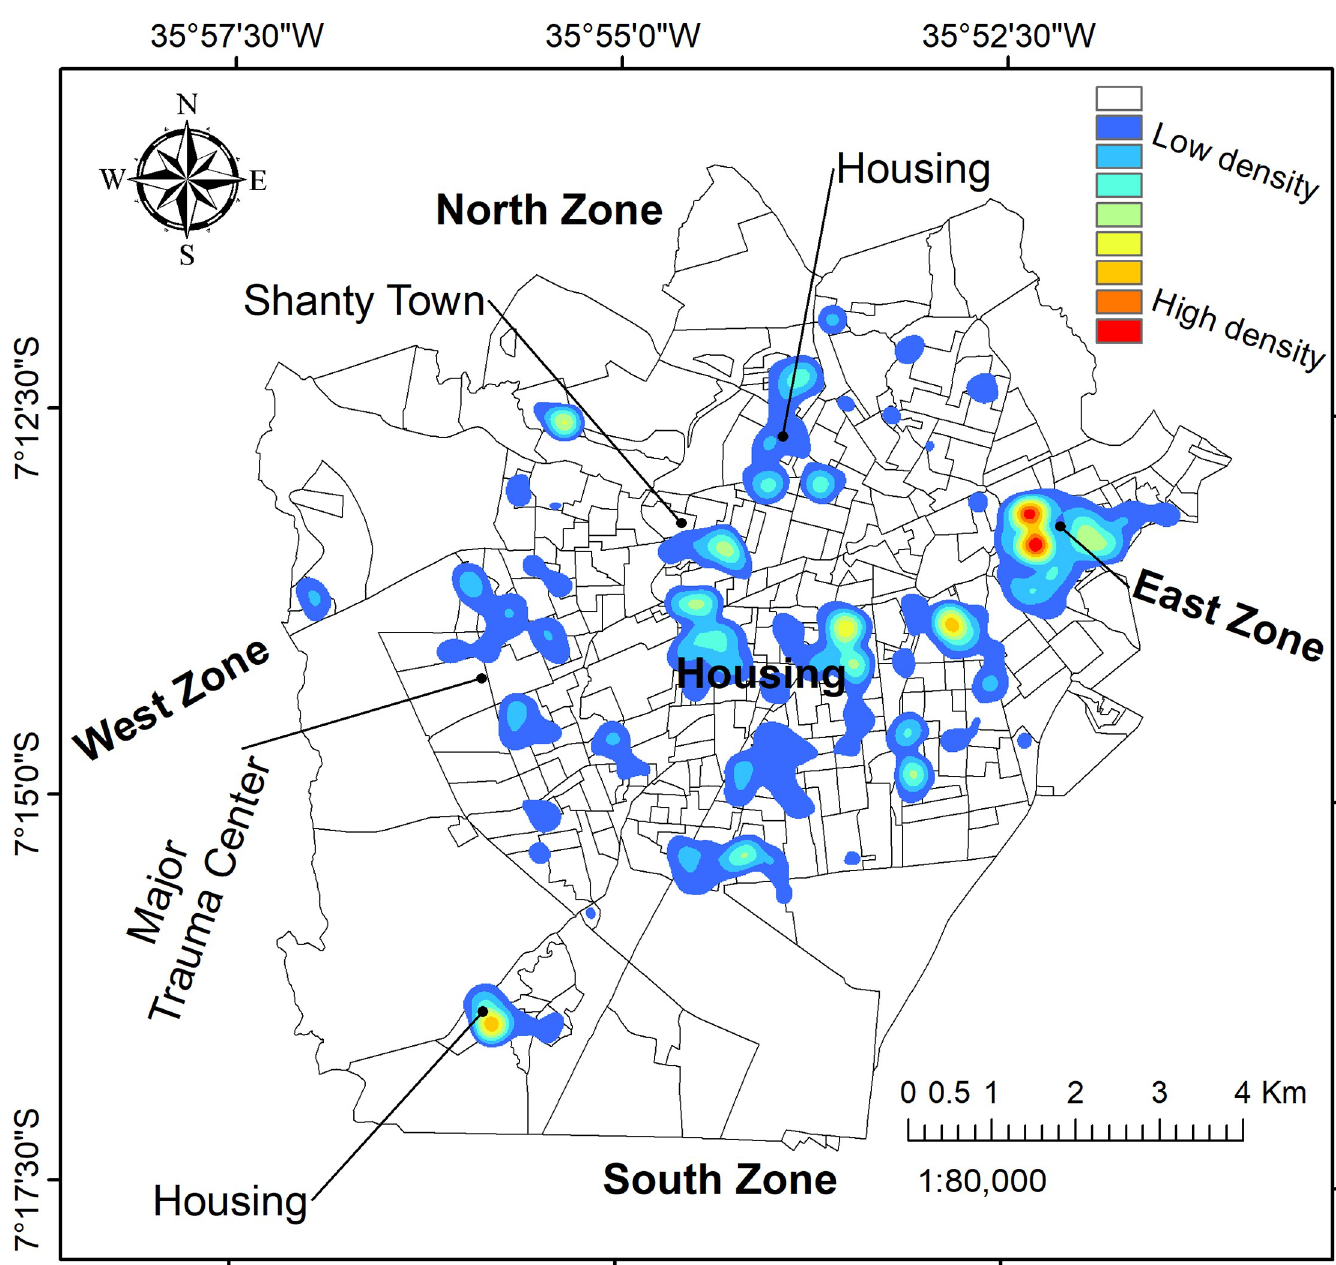
Fig 7. Local Moran’s I hotspots for all physical violence cases by victim’s household address.